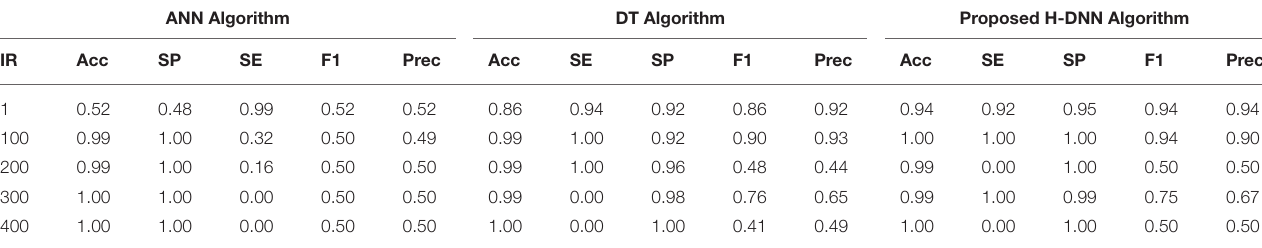
TABLE 8 | ANN and DT results using virus dataset. ANN